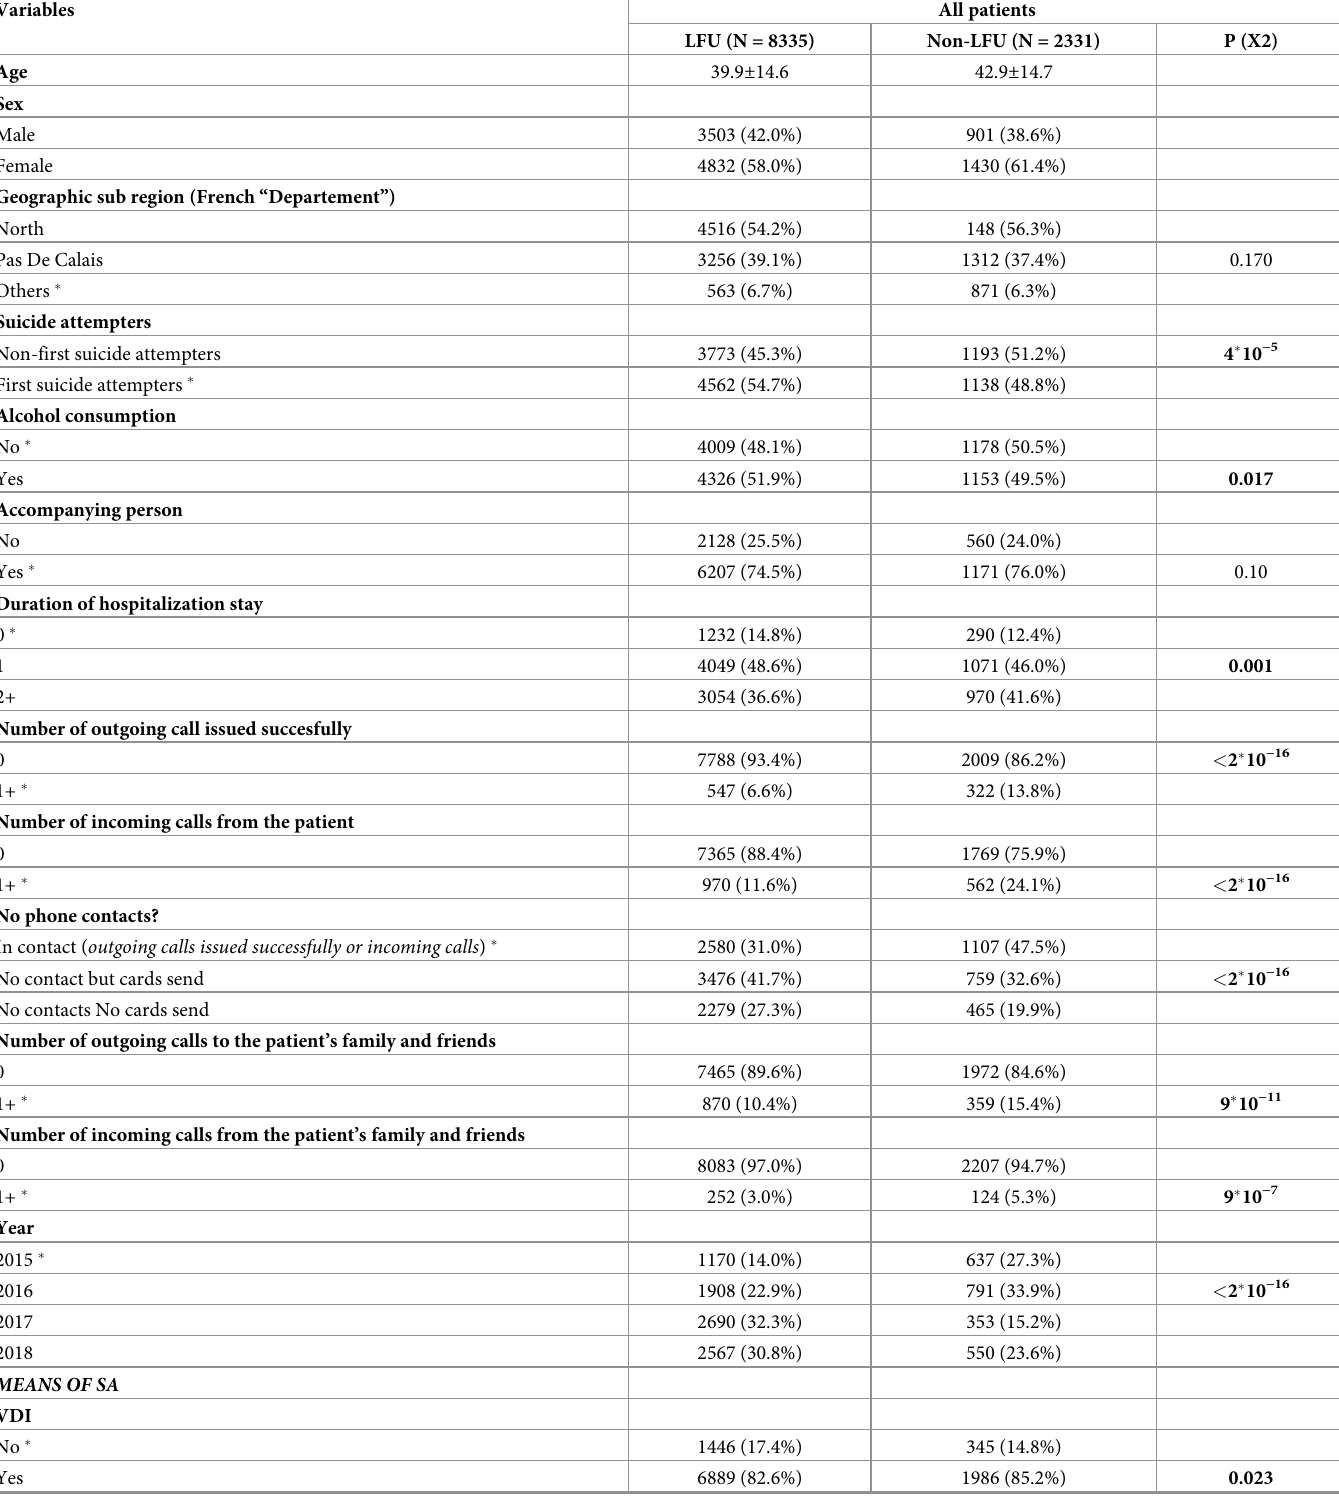
Table 2. Comparison of general characteristics of lost to follow-up and non-lost to follow-up patients and simple age and sex-adjusted logistic regression. Variables